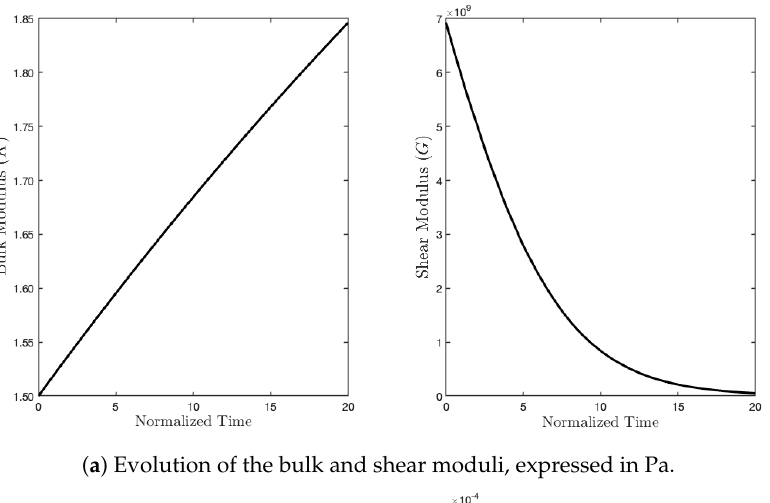
Figure 5. Deformed shape for the pure hydrostatic case (plots were obtained with a scale factor of 20). As we expected, the parameter K , during the evolution subject to such a mechanical load, denoted by q 0 , increased due to a sufficiently high level of external action, which, in turn, produced a positive stimulus for this parameter. On the contrary, since the energy contribution of the deviatoric part is null, the related stimulus was negative, and therefore, the shear modulus started to fade (see Figure 6).